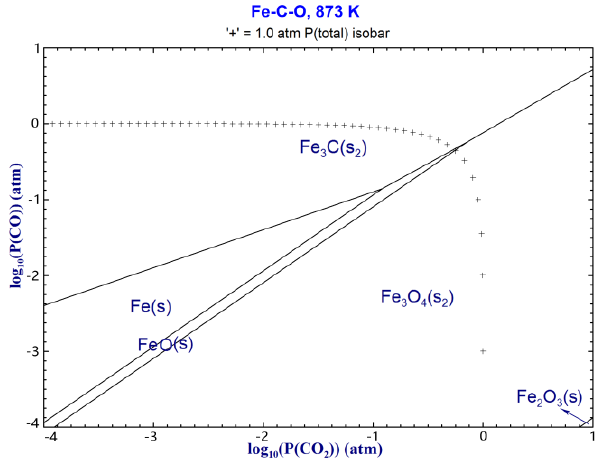
Figure 3. Predominance area diagram of Fe–C–O system at 600 °C (873 K).